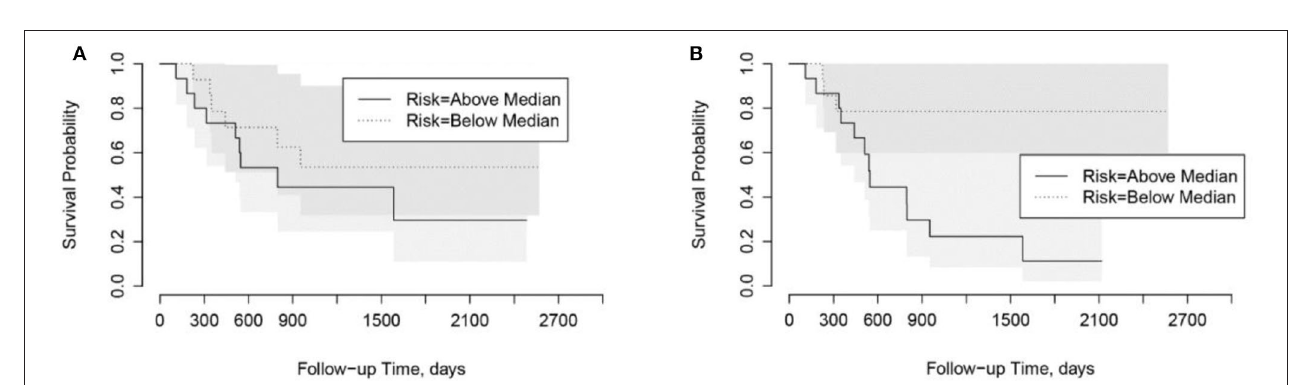
Frontiers in Artificial Intelligence |